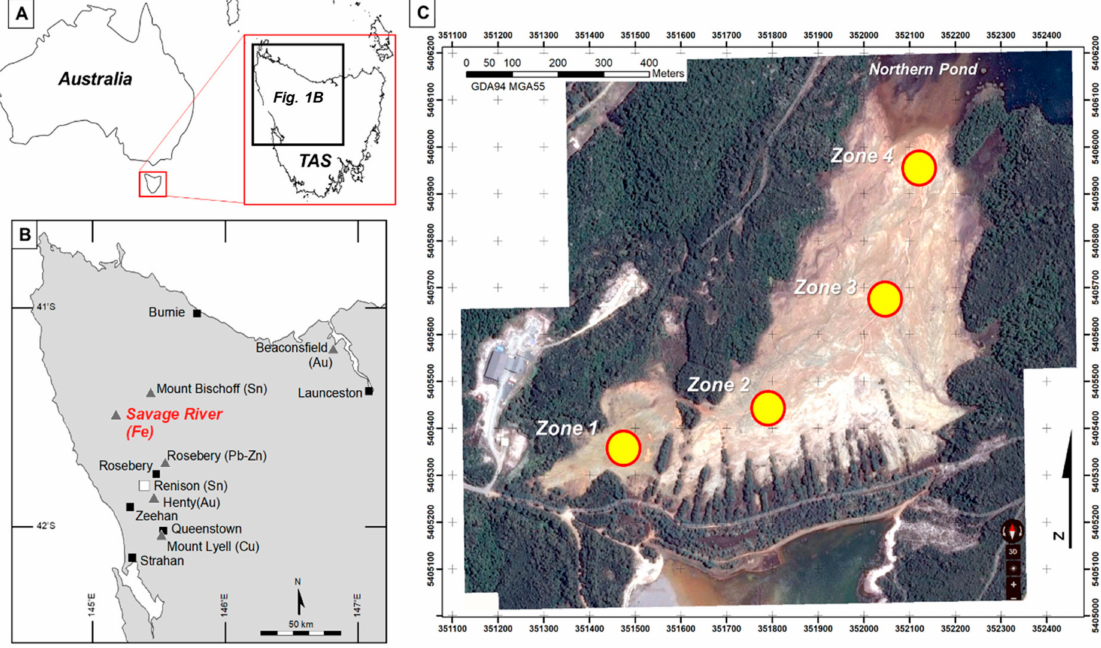
Figure 1. ( A ) Location of Tasmania in Australia; ( B ) Location of Savage River in Western Tasmania showing the location of other major mines and their commodities; ( C ) Image of the Old Tailings Dam (OTD) with the location of samples collected in this study marked with yellow